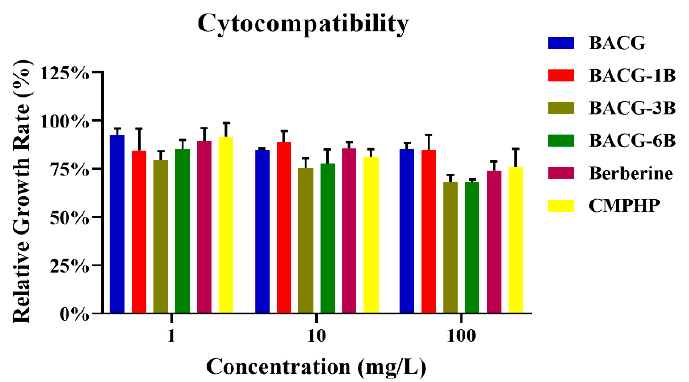
Figure 6. Cytocompatibility of hemostatic materials and drugs.